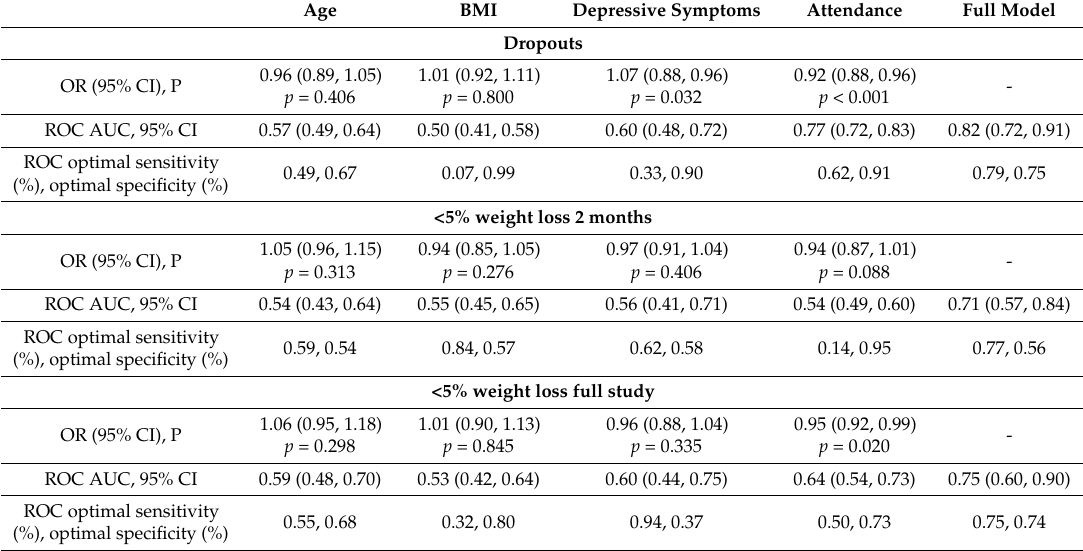
Table 4. Multivariate logistic regression models and receiver operator characteristics curves assessing the association of baseline participant characteristics with dropout status and achieving 5% weight